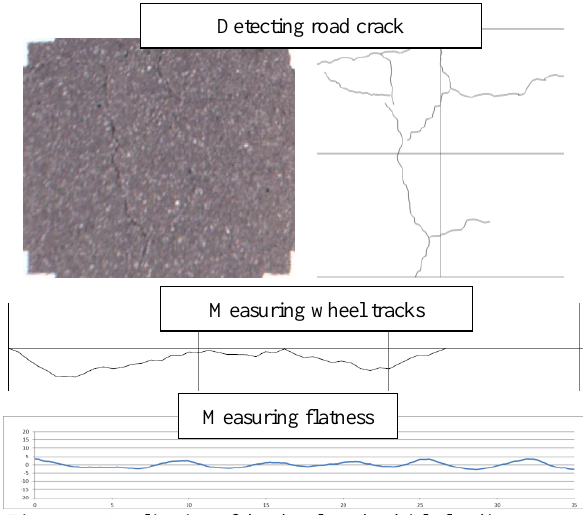
Figure 11. Application of the developed vehicle-loading system utilized in road surface inspection